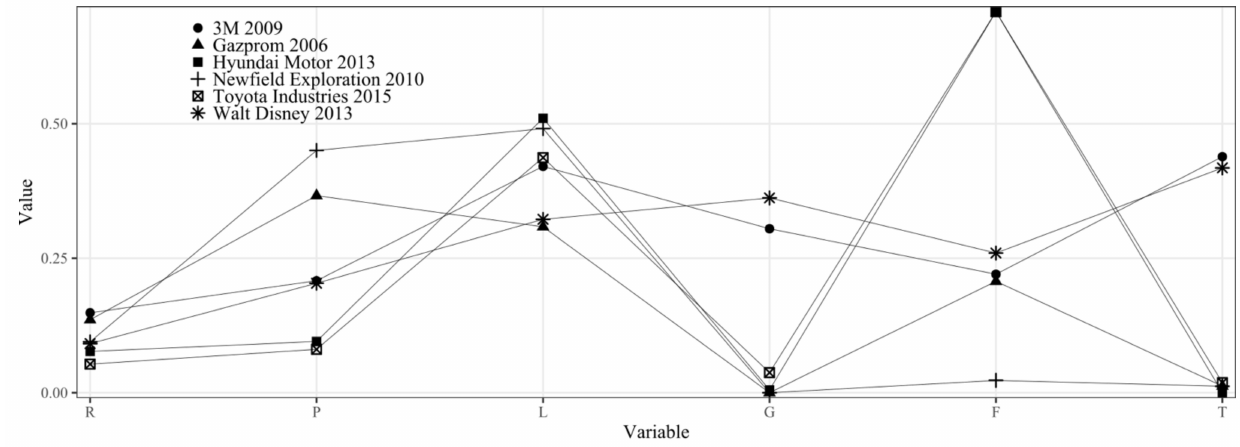
Figure 2. Illustration of clustering in parallel coordinates. Three clusters can be distinguished